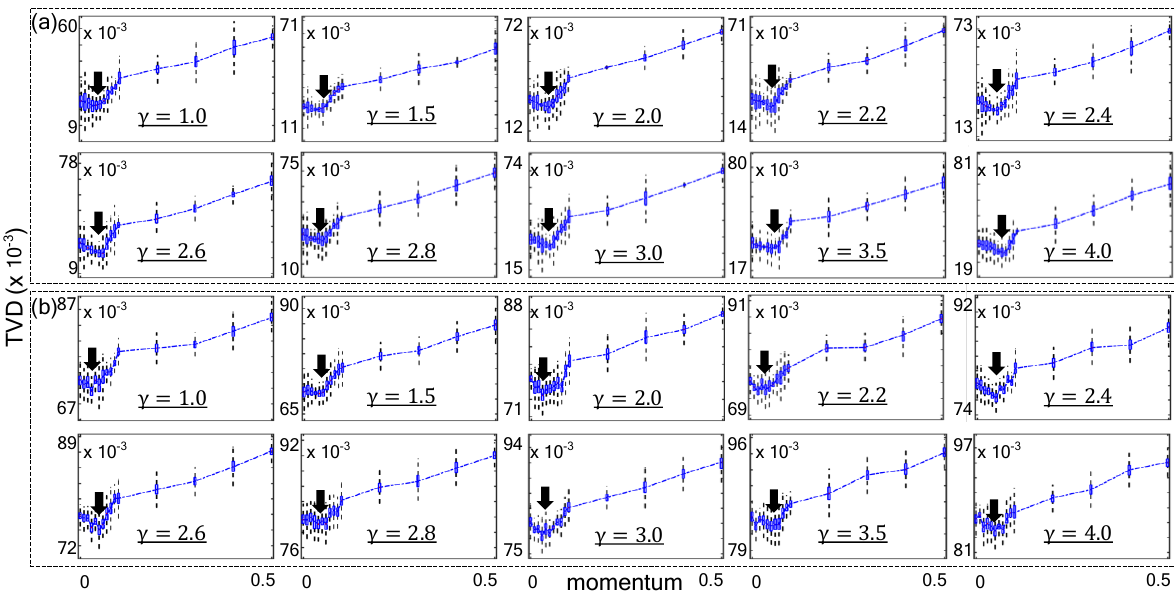
Figure 4. Results of sampling with various momentum parameters on huge synthetic scale–free networks with γ . ( a ) Syn- thetic networks with | n | = 50,000,000 ( b ) | n | =